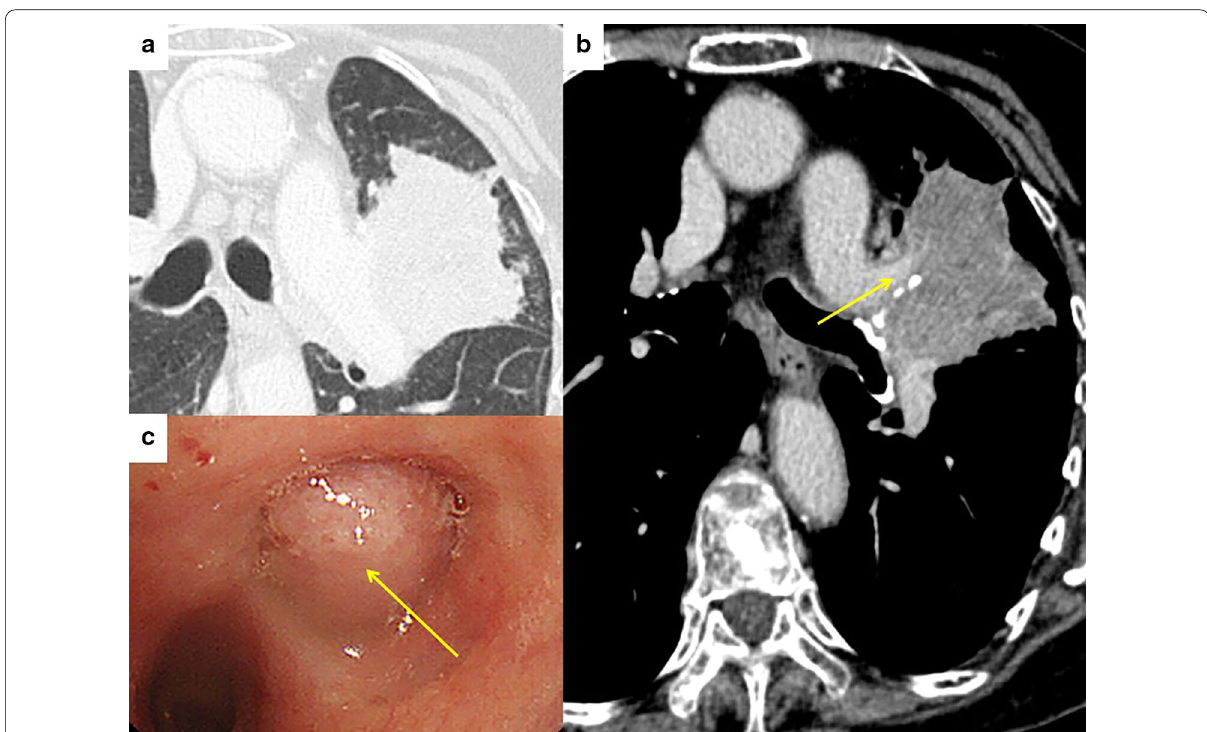
Fig. 1 Pre-treatment enhanced chest computed tomography showed a solid mass measuring 6.2 cm in maximal diameter in the left-upper lobe ( a ) accompanied by narrowing of the left-upper lobe pulmonary artery surrounded by the mass ( b ). Bronchoscopy findings showed that the